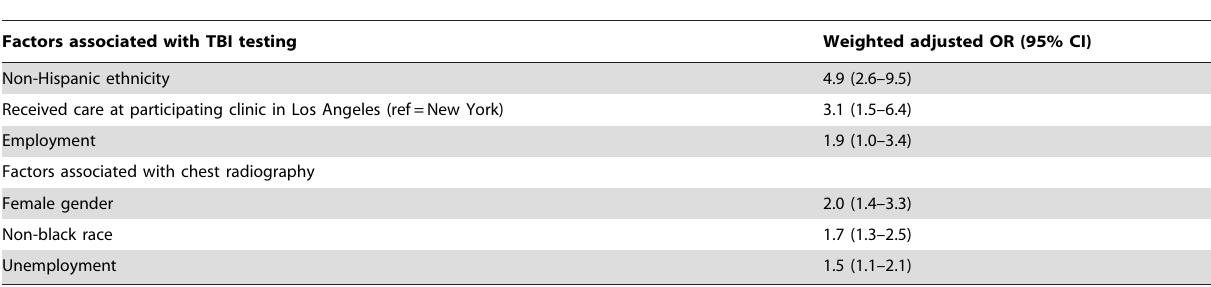
Table 3. Patient-level factors associated with TBI testing, and chest radiography.